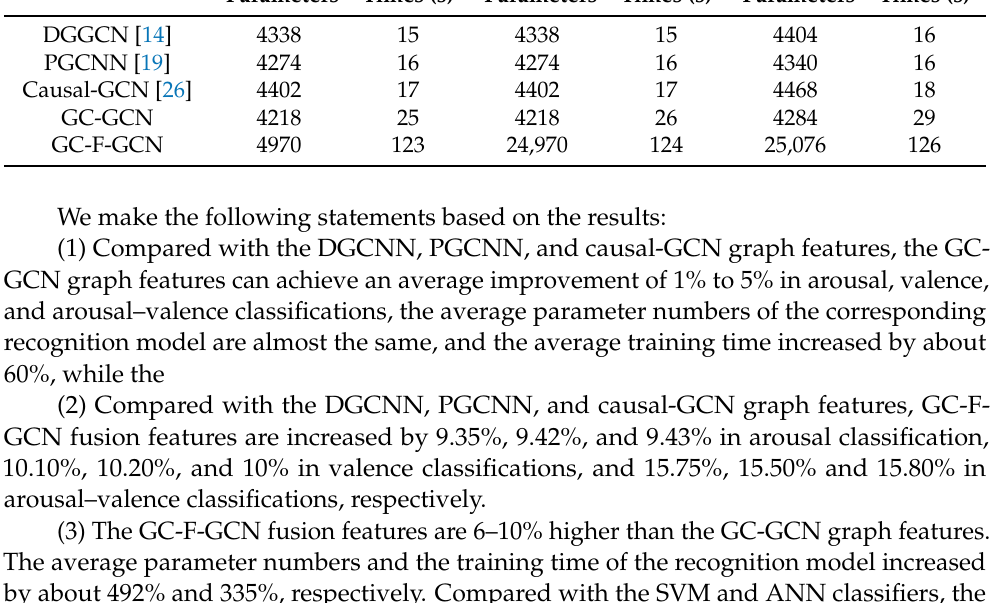
The average parameter numbers and the training time of the recognition model increased by about 492% and 335%, respectively. Compared with the SVM and ANN classifiers,